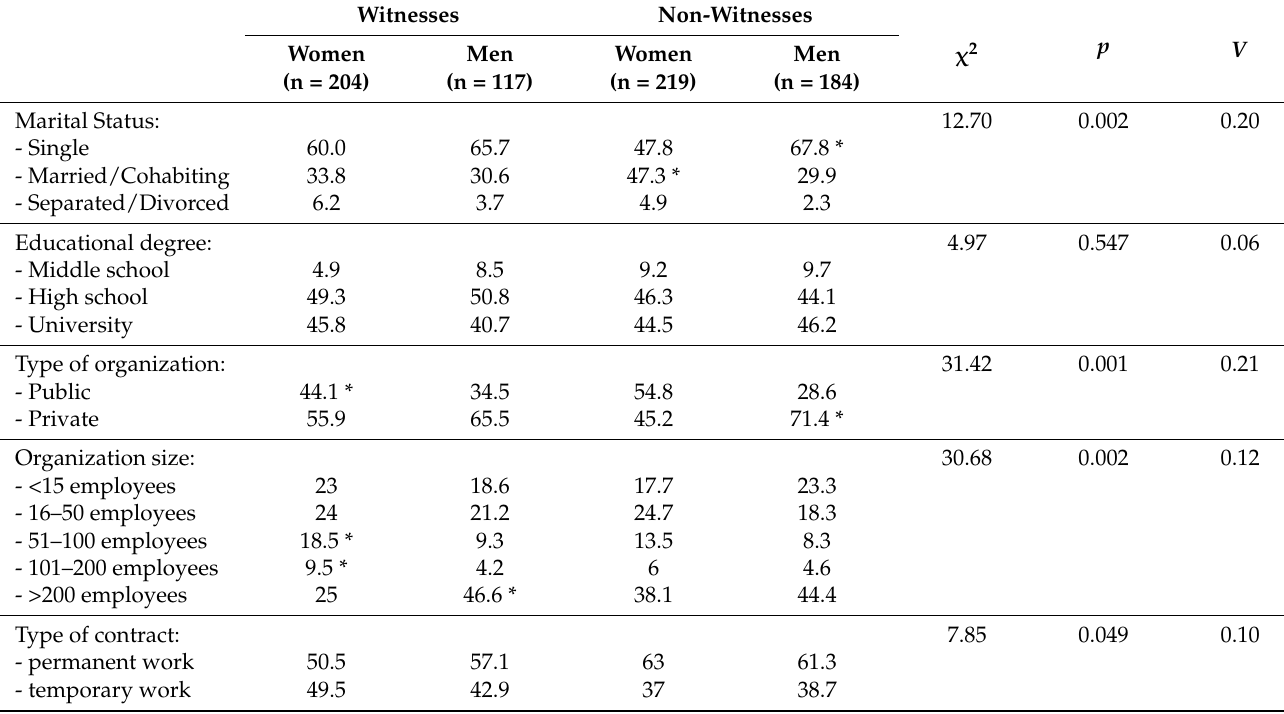
Table 1. Characteristic of the participants (N = 724). Values expressed in column percentage.